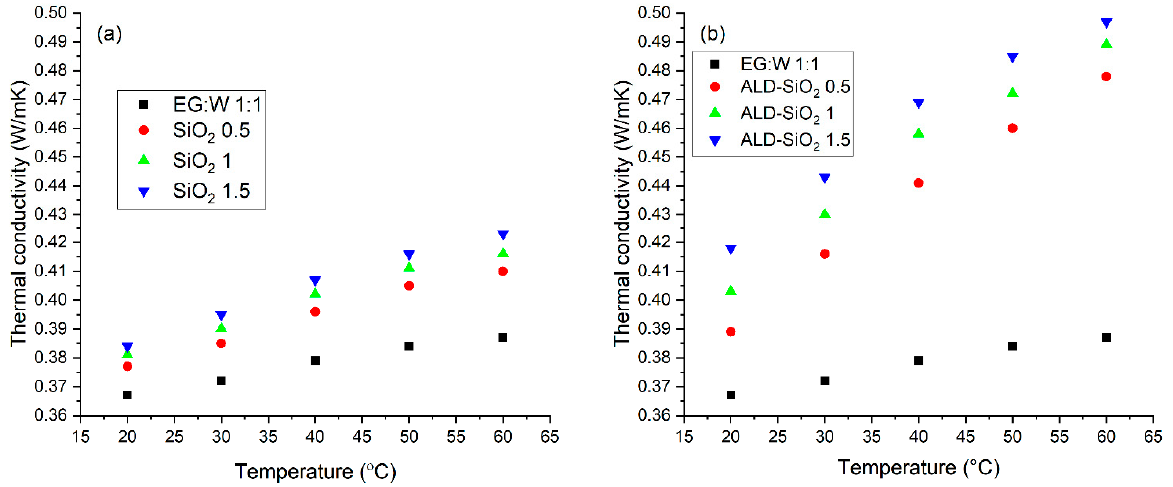
Figure 8. Thermal conductivity of the SiO 2 ( a ) and the composite ( b ) nanofluids.